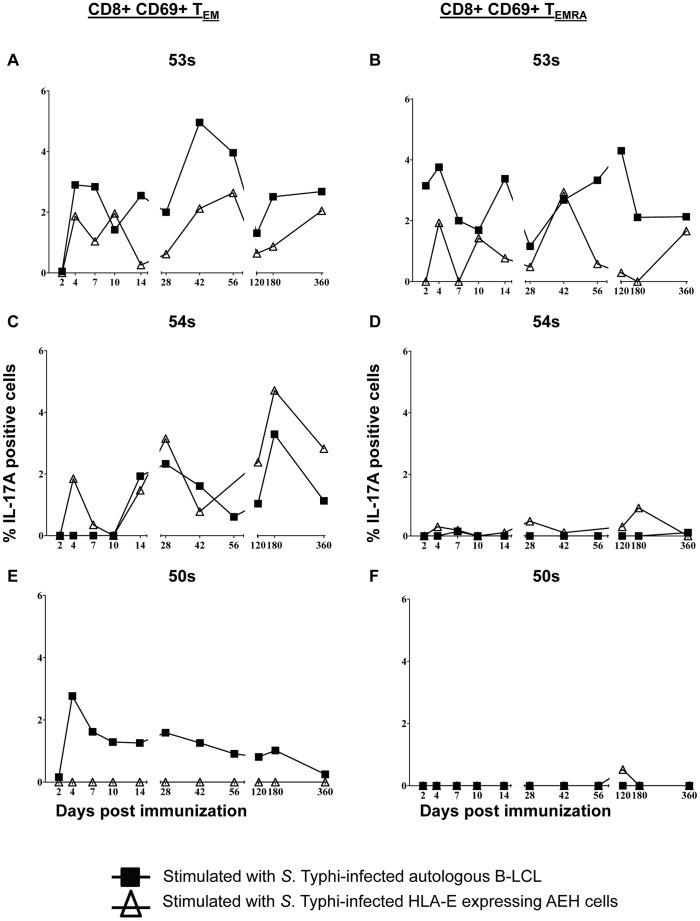
Kinetics of intracellular IL-17A production following stimulation with either S. Typhi-infected autologous B-LCL or HLA-E restricted cells.Intracellular cytokine/chemokine production is shown as the percentage of positive cells. Responses are expressed as net values with day 0 subtracted to normalize for differences in base-line responses to S. Typhi in different volunteers. Responses to S. Typhi-infected autologous B-LCL are indicated by a filled square (▪) and responses to S. Typhi-infected HLA-E restricted cells are indicated by open triangles (▵). A) CD8+ TEM cells for volunteer 53 s B) CD8+ TEMRA cells for volunteer 53 s C) CD8+ TEM cells for volunteer 54 s D) CD8+ TEMRA cells for volunteer 54 s E) CD8+ TEM cells for volunteer 50 s F) CD8+ TEMRA cells for volunteer 50 s. Increases of >0.5% cytokine positive cells over uninfected targets were found to be statistically significant (P<0.01).